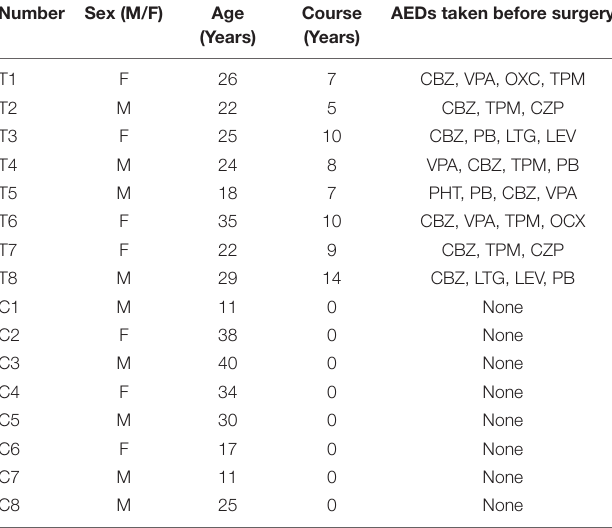
TABLE 1 | Clinical characteristics of patients with intractable TLE and control